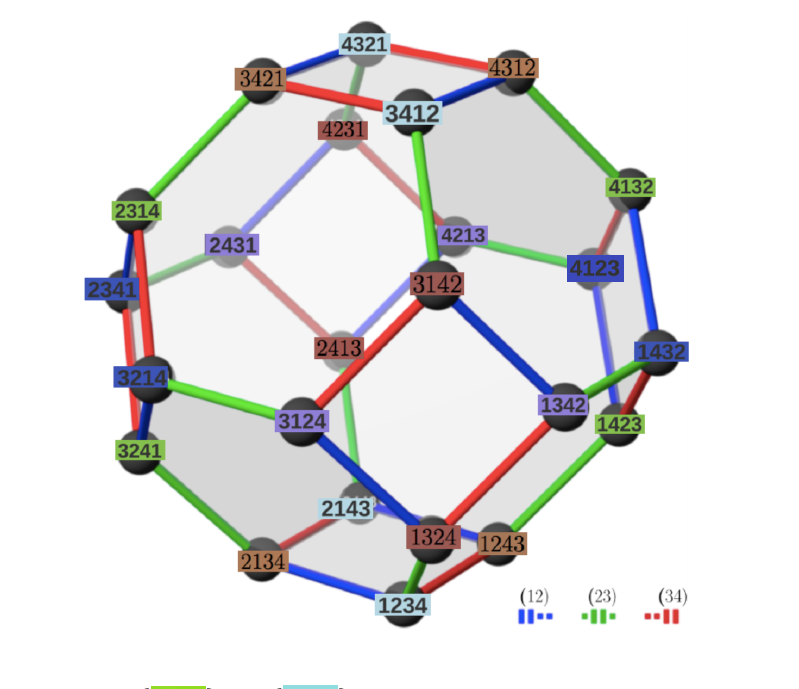
Figure 8 . { } · · · { } addressesadorning the